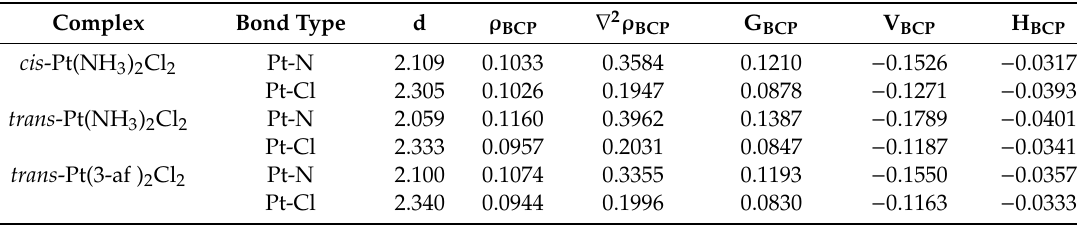
Figure 4. Molecular graphs of cisplatin ( a ), transplatin ( b ) and trans -Pt(3-af ) 2 Cl 2 ( c ) calculated at the B3LYP/def2-TZVPP level. Selected geometric and QTAIM parameters for cisplatin, transplatin and trans –Pt(3-af) 2 Cl 2 complex: bond lengths (d, in Å), electron density ( ρ BCP , in e Å − 3 ), Laplacian of electron density ( ∇ 2 ρ BCP , in e Å − 5 ), kinetic (G BCP in hartree Å − 3 ), potential (V BCP in hartree Å − 3 ) and total energy density(H BCP in hartree Å − 3 ) at the respective BCPs.